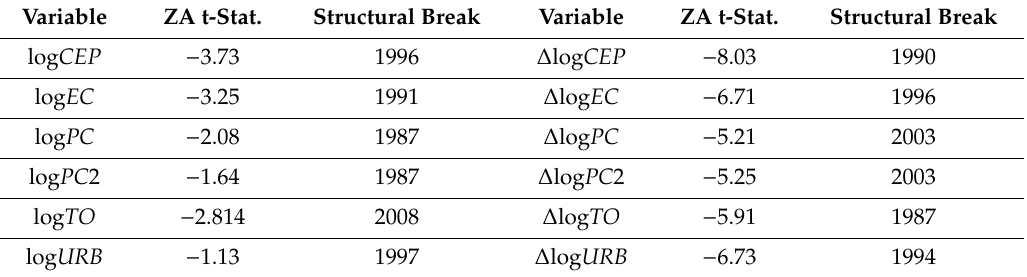
Table 1. Unit root results with structural break.